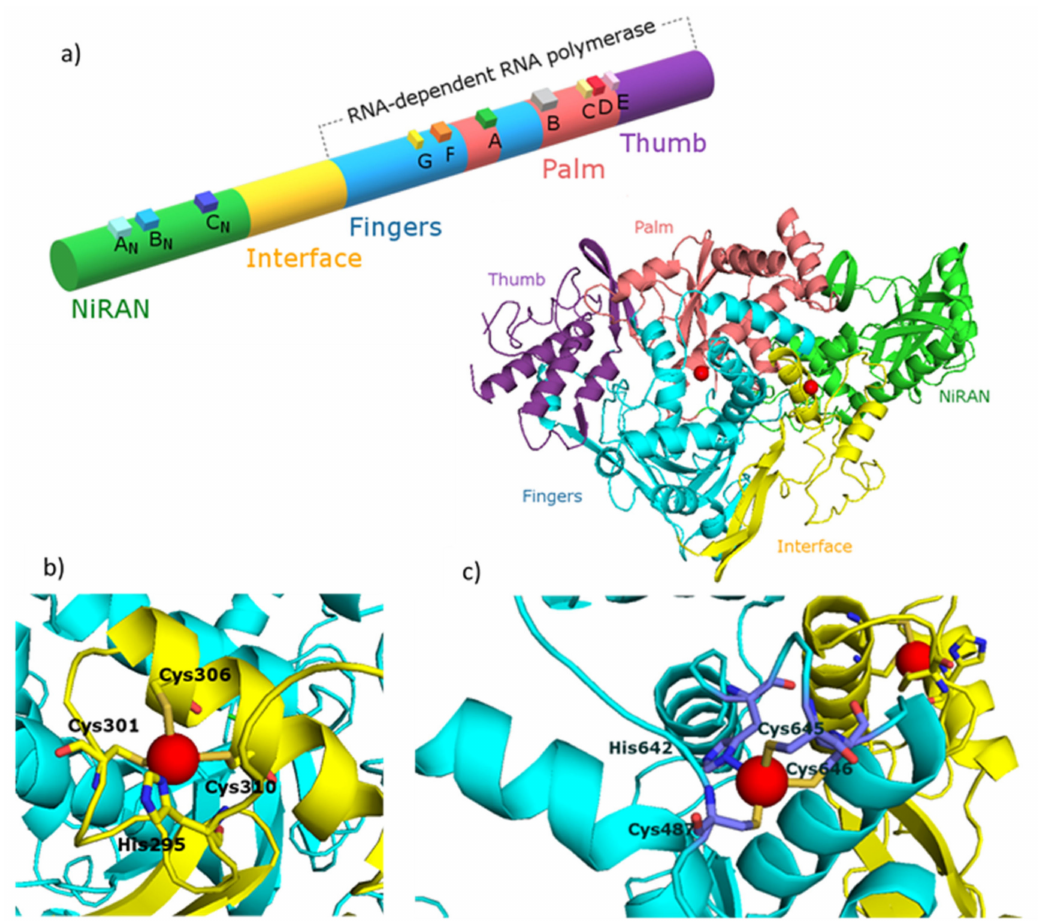
Figure 1. ( a ) Diagram and structure of the SARS-CoV nsp12 protein indicating protein domains (NiRAN, interface, fingers, thumb and palm), conserved motifs (A N , B N , C N , G, F, A, B, C, D) and zinc(II) binding sites (red spheres). Enlarged zinc(II) binding sites of nsp12 protein placed in: ( b ) interface region and ( c ) fingers region. The figure was generated using PyMOL [41]. PDB entry: 7BTF [42]. Figures based on